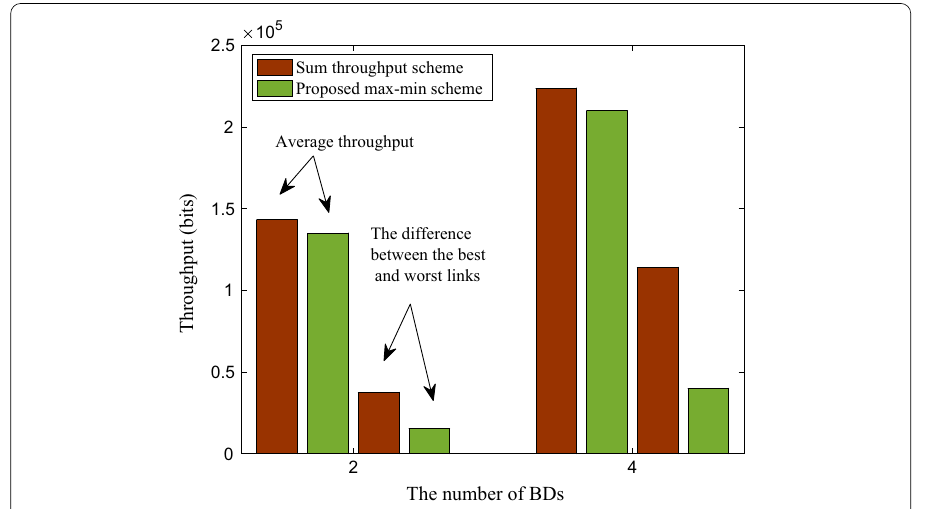
Fig. 7 Comparison of throughput under max–min scheme and sum throughput maximization